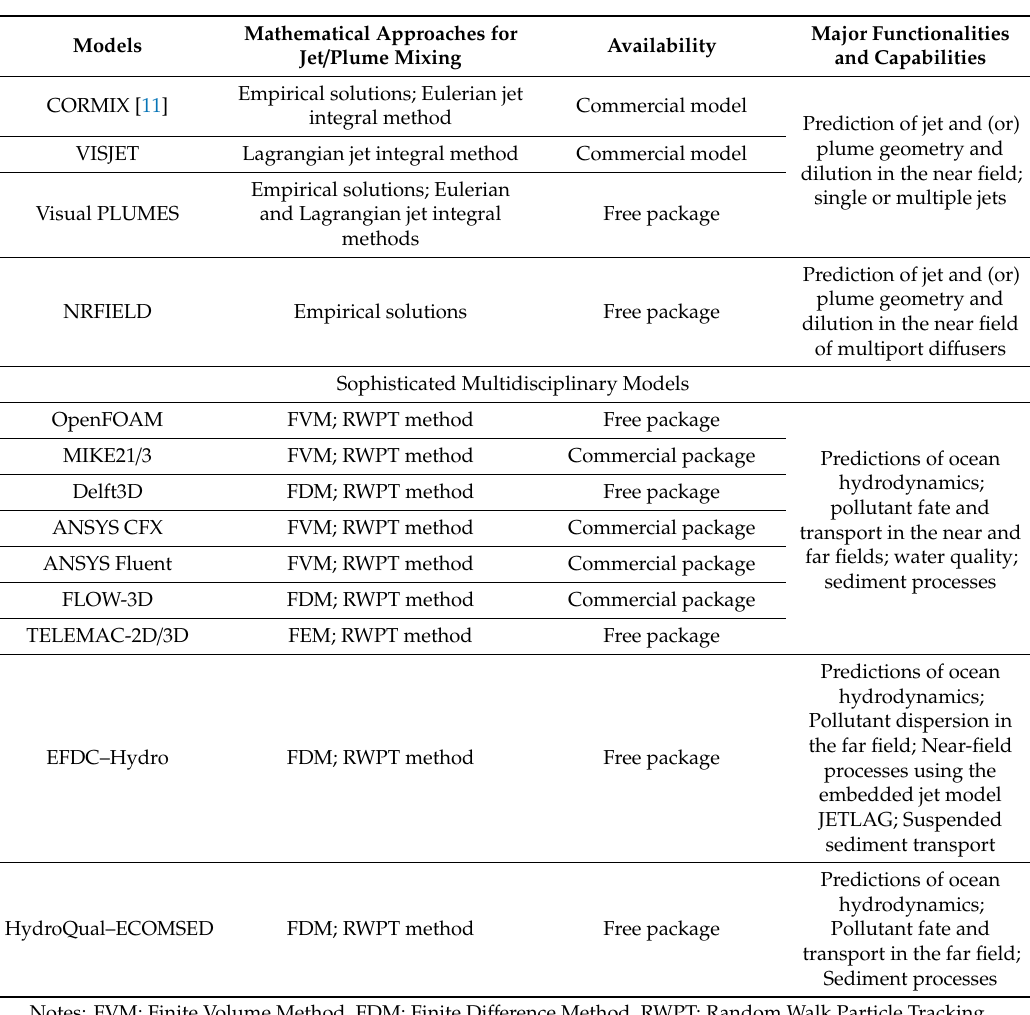
Table 1. Existing modeling packages for simulation of jet and plume